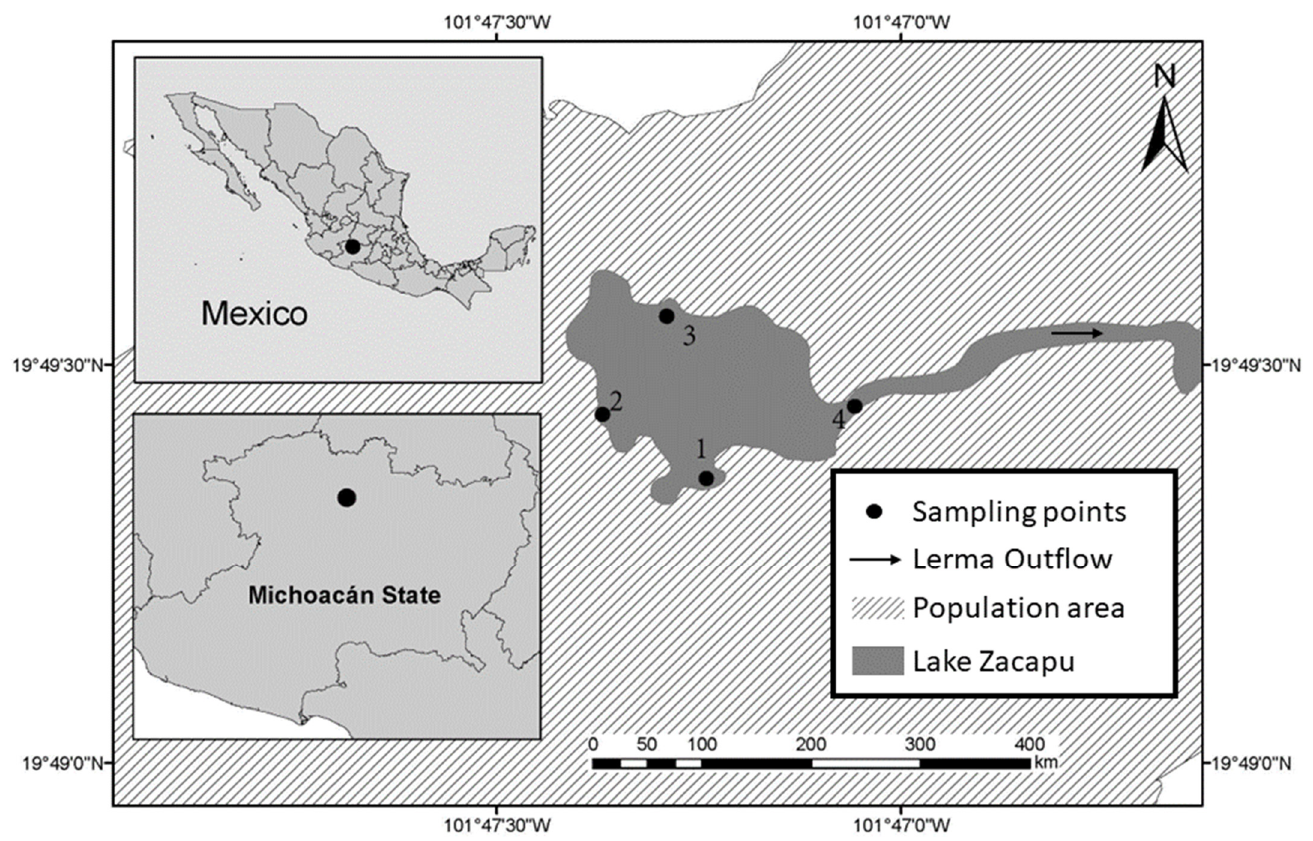
Figure 1. The geographical location of the study area and sampling sites (S1–S4) are located in Lake Zacapu, Michoacán, México.